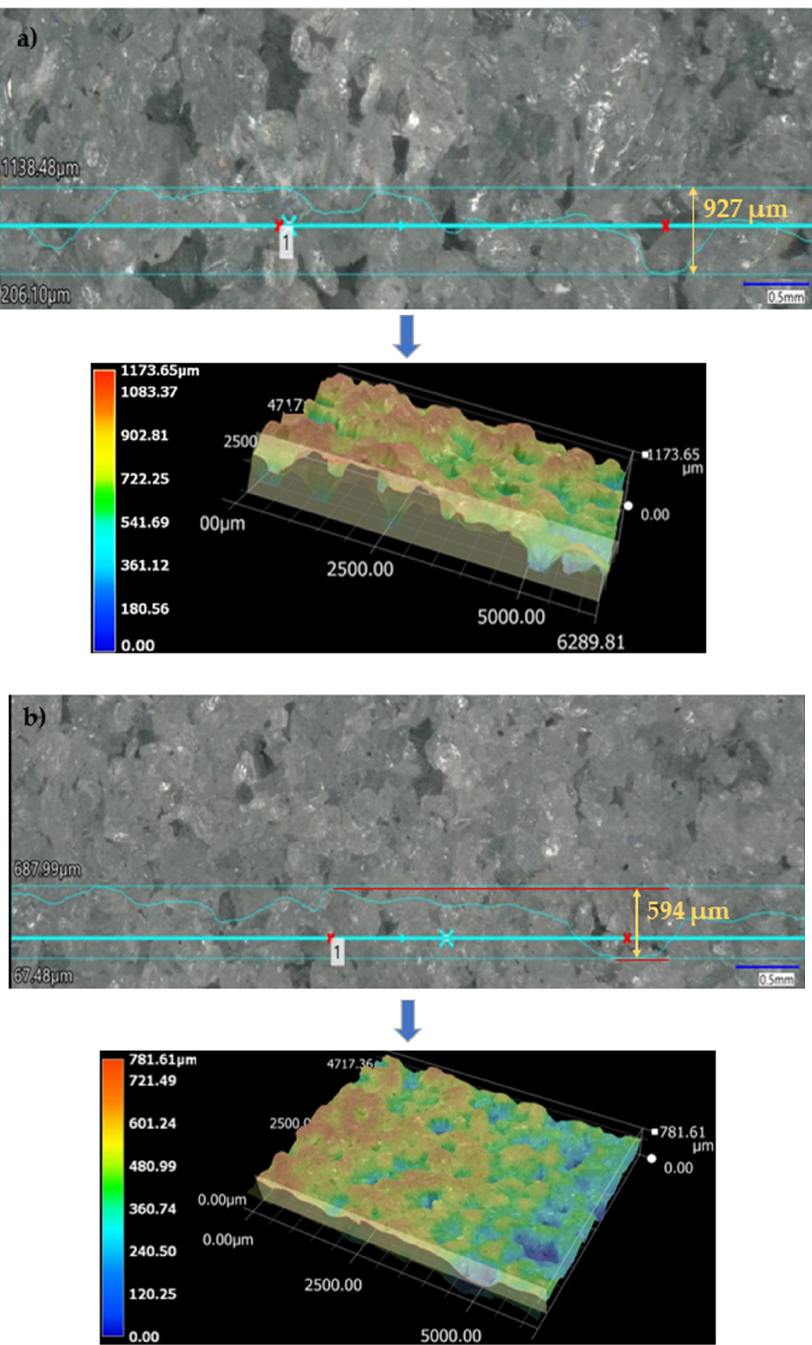
Figure 3. Active surface area of ( a ) a conventional and ( b ) a multigranular grinding wheel.